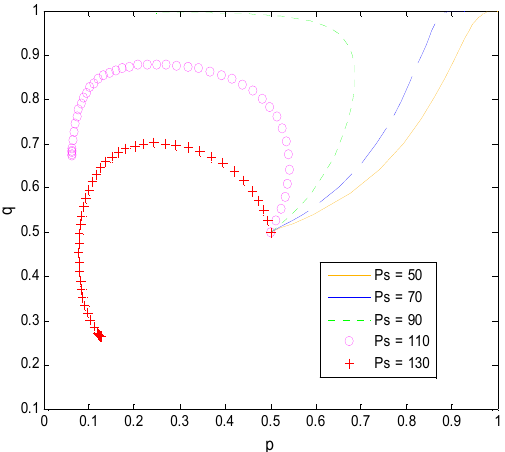
Figure 9. The evolution process of the change of p s